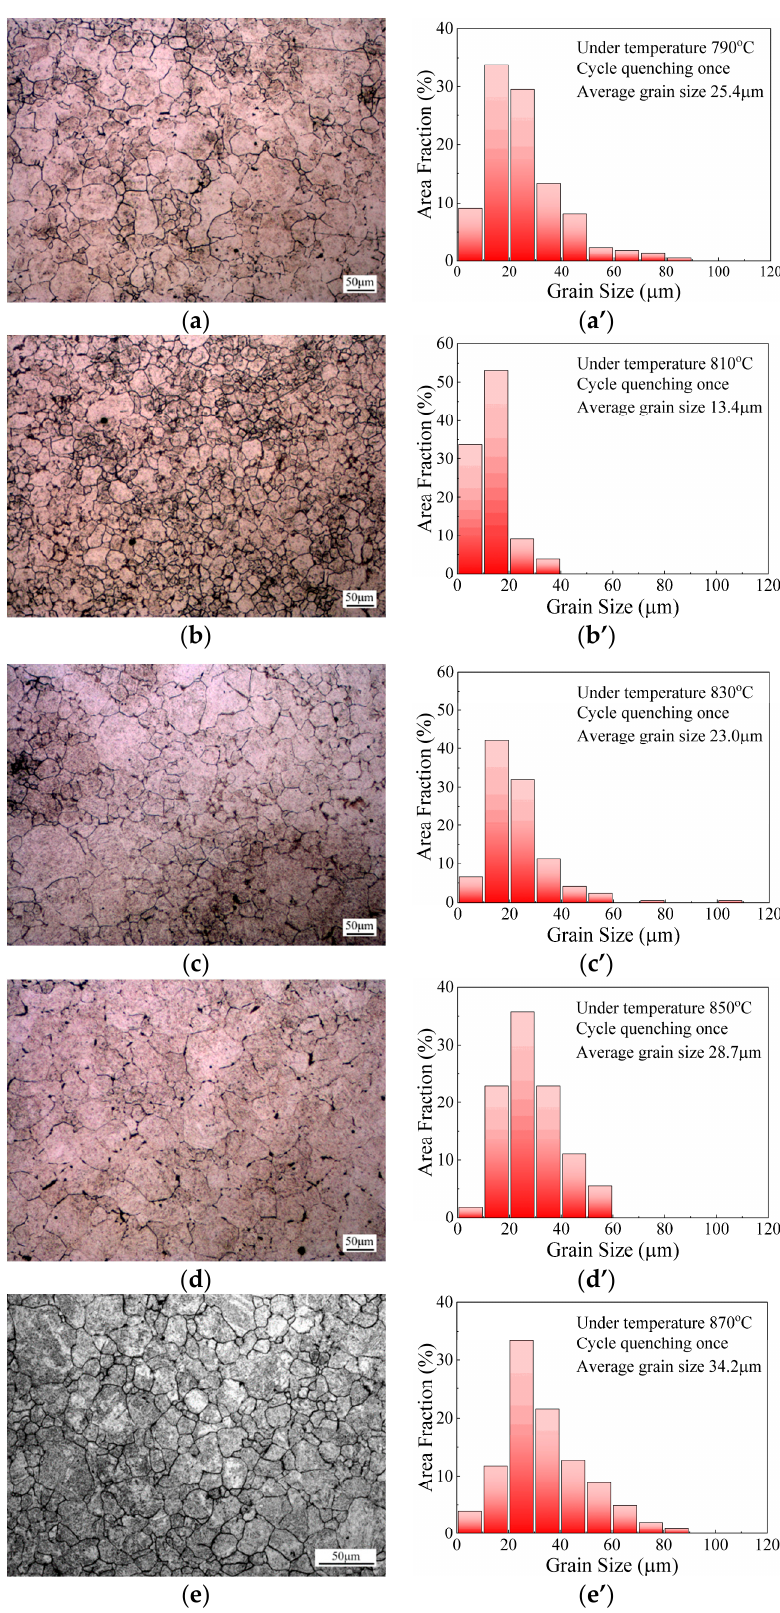
Figure 8. Microstructures and grain size distributions of specimens subjected to single quenching treatment under different cyclic quenching temperatures: ( a )-( a’ ) 790 °C; ( b )-( b’ ) 810 °C; ( c )-( c’ ) 830 °C; ( d )-( d’ ) 850 °C; ( e ) 870 °C.